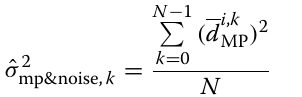
Pseudorange multipath error and measurement noise estimation